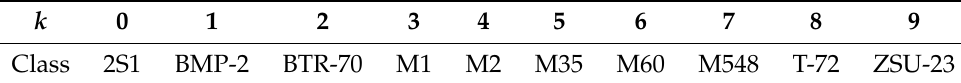
Table 1. SAMPLE dataset target classes ( k